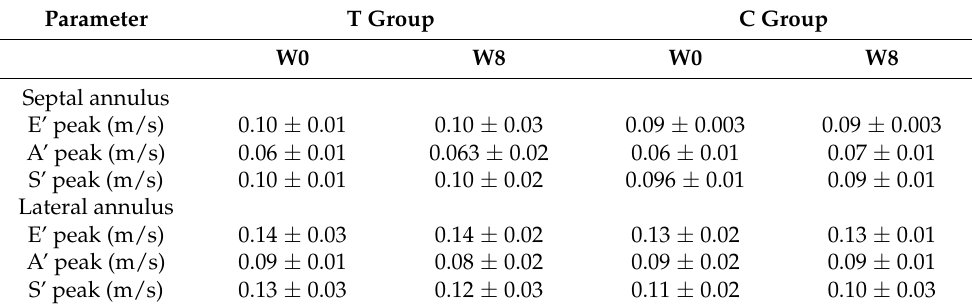
Figure 3. Volumetric changes in the heart in dogs submitted to 8-week endurance training program. ( A ) LVVd: left ventricular volume in diastole; ( B ) LVVs: left ventricular volume in systole; ( C ) SV: systolic volume; ( D ) EF: ejection fraction in milliliter (mL) and percentage (%). *: Difference from week zero (W0); ( p < 0.05). Table 3. Doppler velocities of the septal and lateral mitral